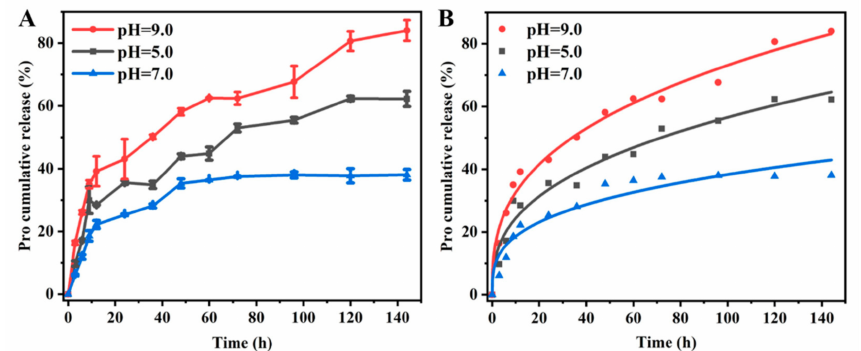
Figure 5. Cumulative release behaviors ( A ) and fitting plots using the Ritger–Peppas equation ( B ) of Pro@BMMs − PMAA/Fe 3+ Nps at different pH